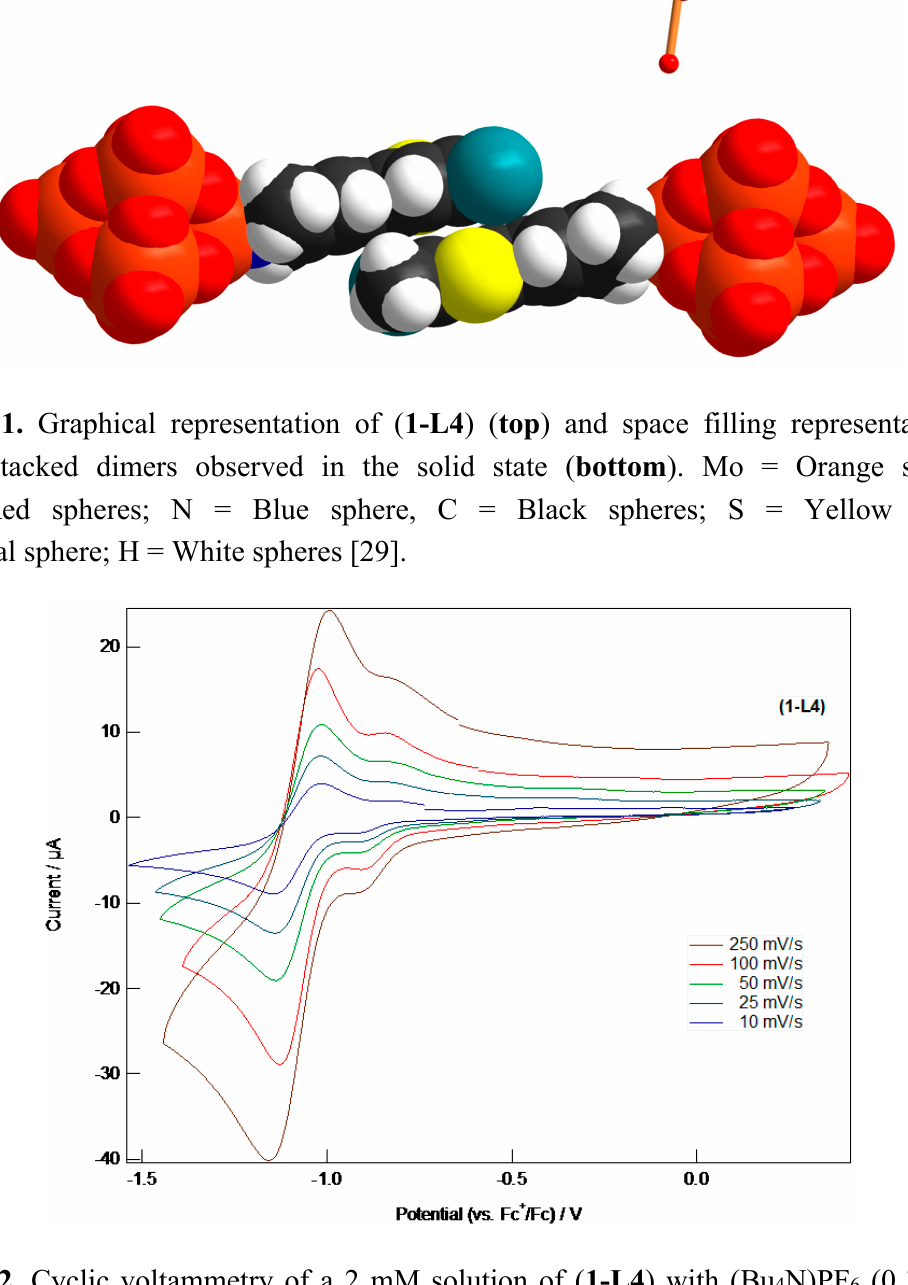
Figure 2. Cyclic voltammetry of a 2 mM solution of ( 1-L4 ) with (Bu 4 N)PF 6 (0.1 M) in CH 3 CN. The scans were recorded from a freshly polished electrode using Pt working (3 mm diameter) and counter electrodes and an Ag pseudo-reference electrode. Potentials were corrected vs.